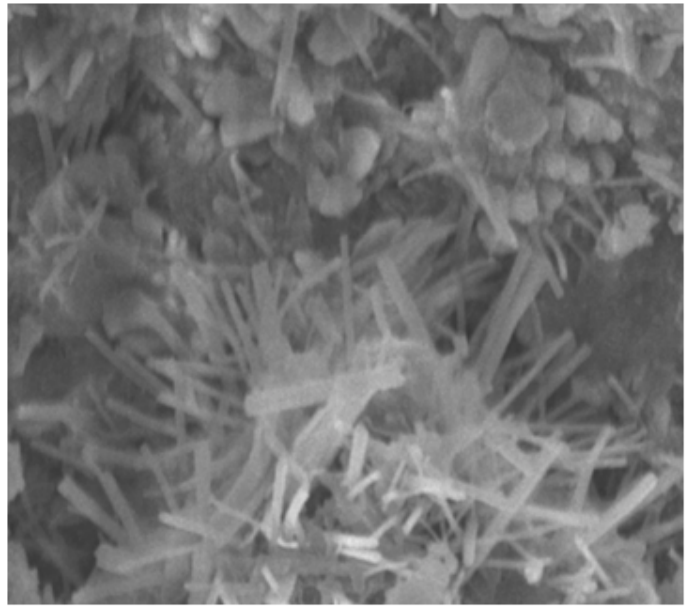
Figure 17. Coconut shell replacement of in concrete (15%).